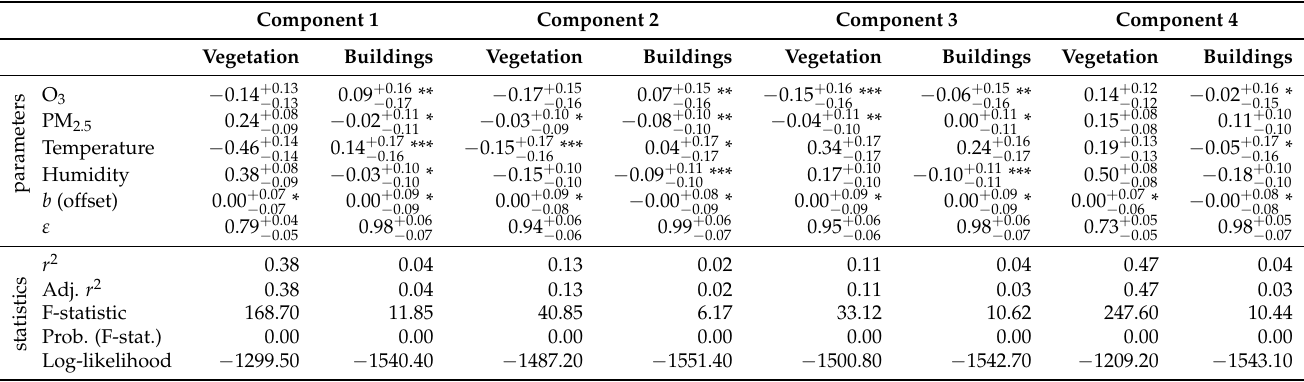
Table 4. Top: MCMC median of atmospheric coefficient parameters to model the PC amplitude of each PCA component at full spectral resolution, together with the 3 σ uncertainty shown as super- and subscripts, which include the full parameter covariance derived from the 3 σ contours in the posteriors provided in Figures S1–S8 in Supplementary Materials. Bottom: Model evaluation statistics for the maximum likelihood solution for vegetation and